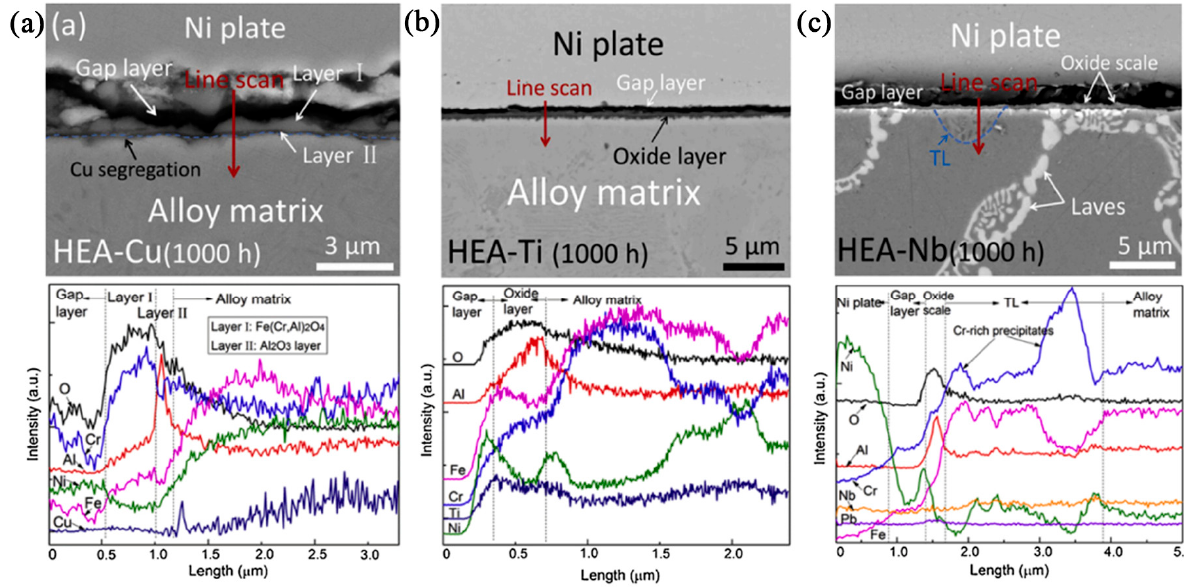
Figure 14. SEM and EDS line-scanning of the cross section of ( a ) AlCrFeNiCu, ( b ) AlCrFeNiTi and ( c ) AlCrFeNiNb after being immersed in 10 − 6 wt.% oxygen containing molten Pb at 600 ◦ C for 1000 h, the red arrows represent the positions of the line-scanning, the blue arrow represent the transitional layer, the different colours of the lines represent different elements, and the dotted lines represent the boundary of the different layers [26].